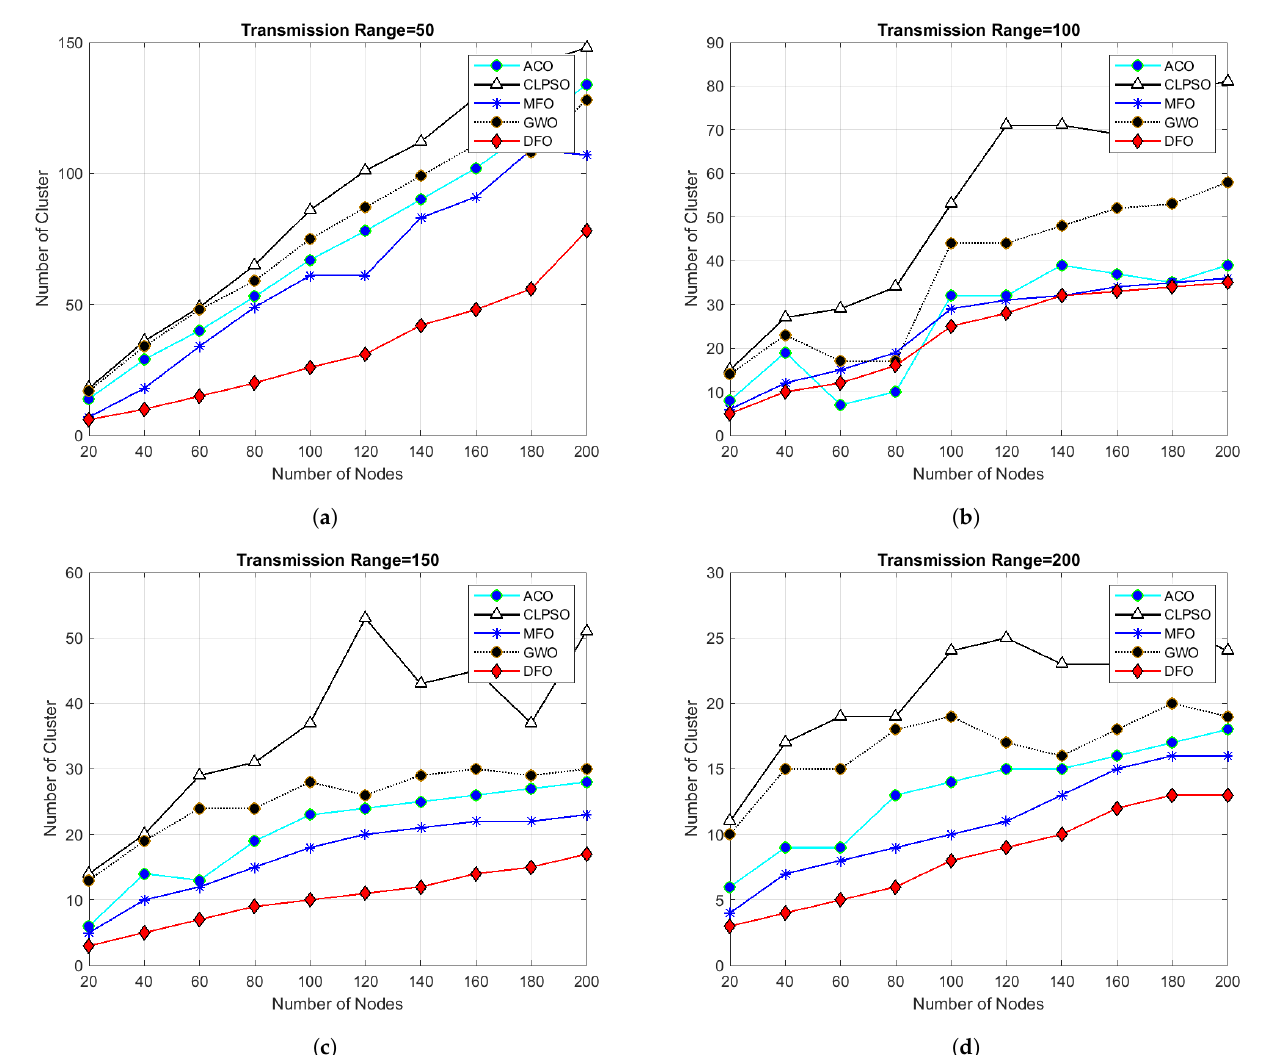
Figure 5. Grid size 1000 m × 1000 m and number of nodes 20 to 200 .